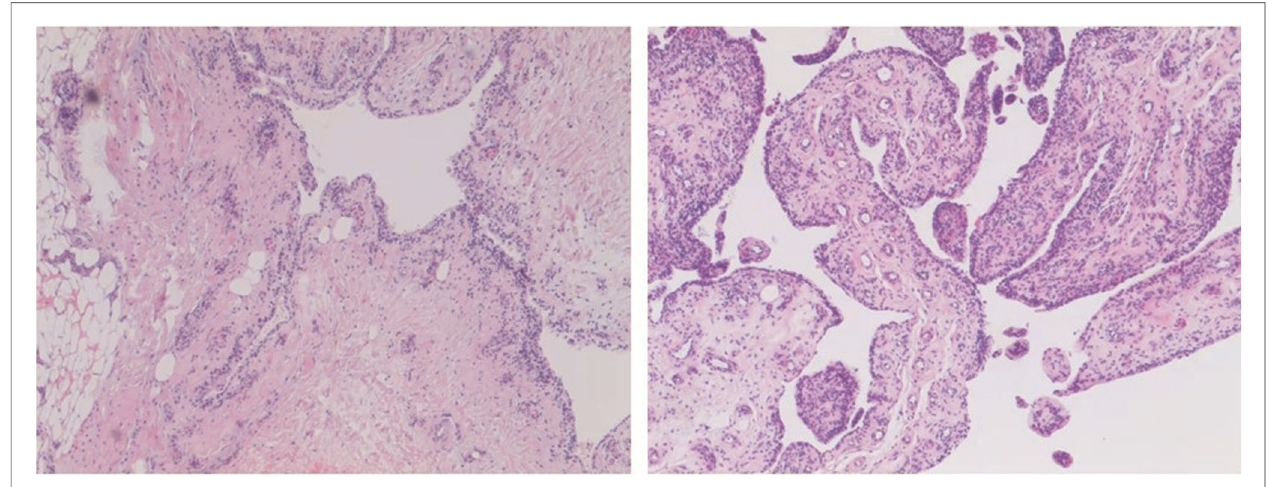
FIGURE 3 | Pathology of the